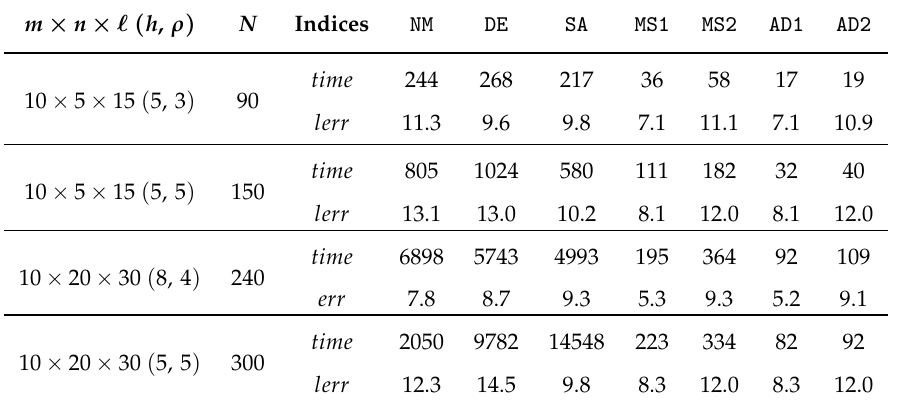
Table 3. Execution times and accuracies for nonnegative CANDECOMP/PARAFAC (CP) problems. m × n × (cid:96) ( h , ρ )